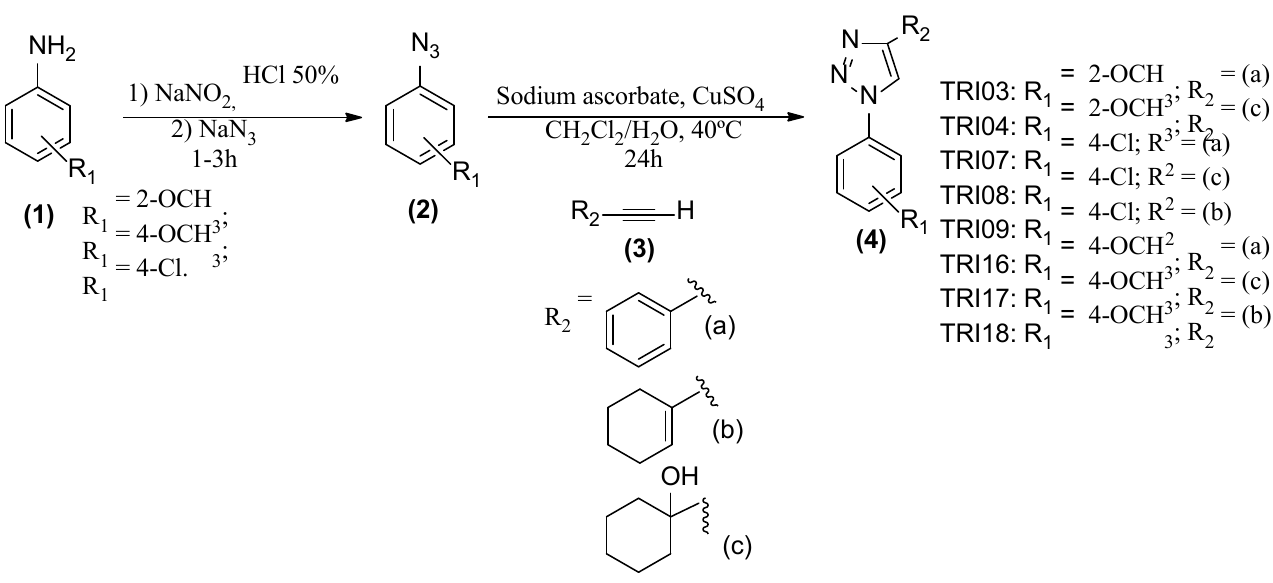
SCHEME 1 - Synthetic route of production of 1,2,3-triazoles